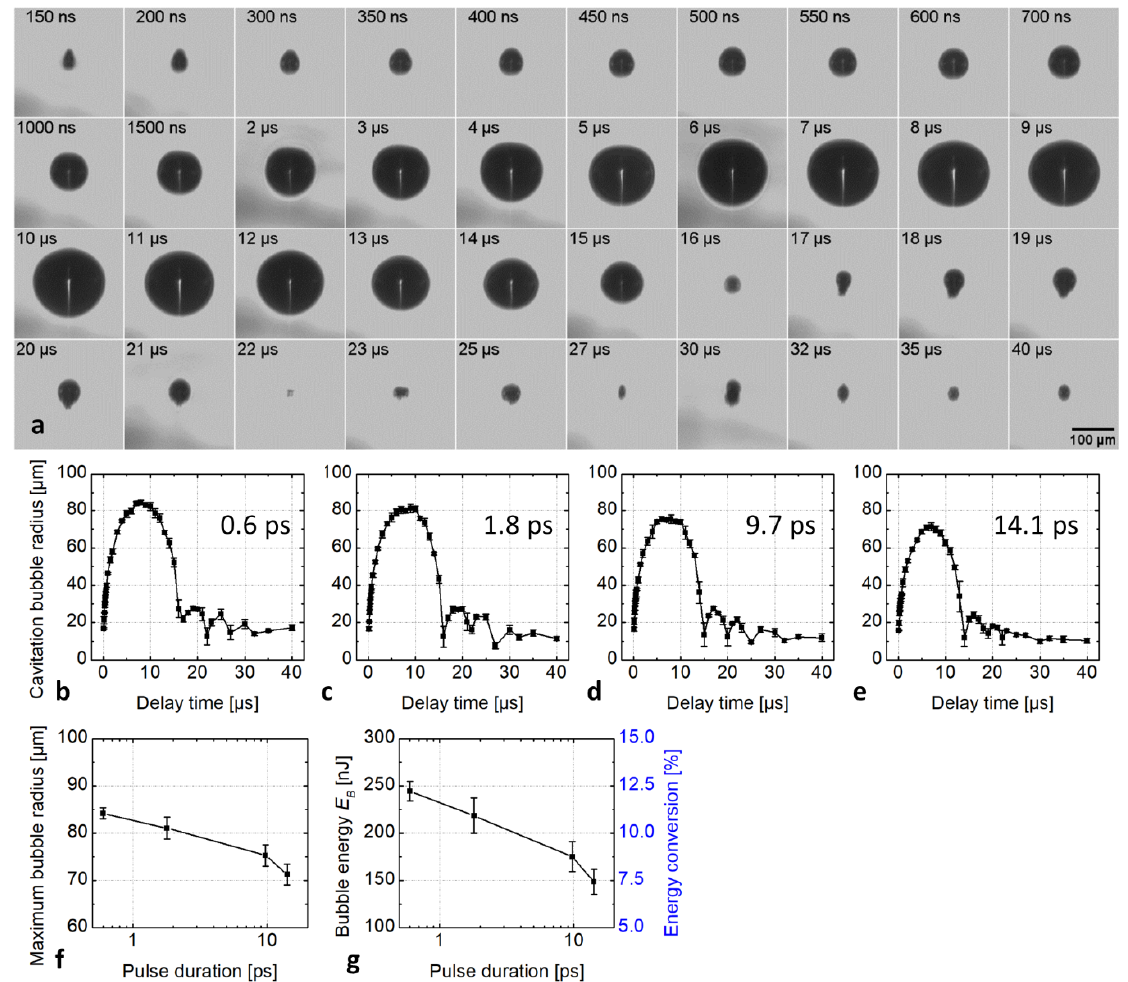
Figure 2. ( a ) Time-resolved images of the cavitation bubble initiated by a 600 fs laser pulse. The laser pulse energy was kept constant at 2.0 µJ and the focus was located 1 mm below the hydrogel surface. The cavitation bubble development at a pulse duration of 1.8, 9.7, and 14.1 ps is similar to that at 600 fs and can be found in Figures S2–S4. ( b – e ) Plots of the cavitation bubble radius generated at different pulse duration versus the delay time. ( f ) The plot of the obtained maximum cavitation bubble radius R max in the hydrogel and ( g ) the bubble energy and the corresponding energy conversion efficiency as a function of pulse duration.